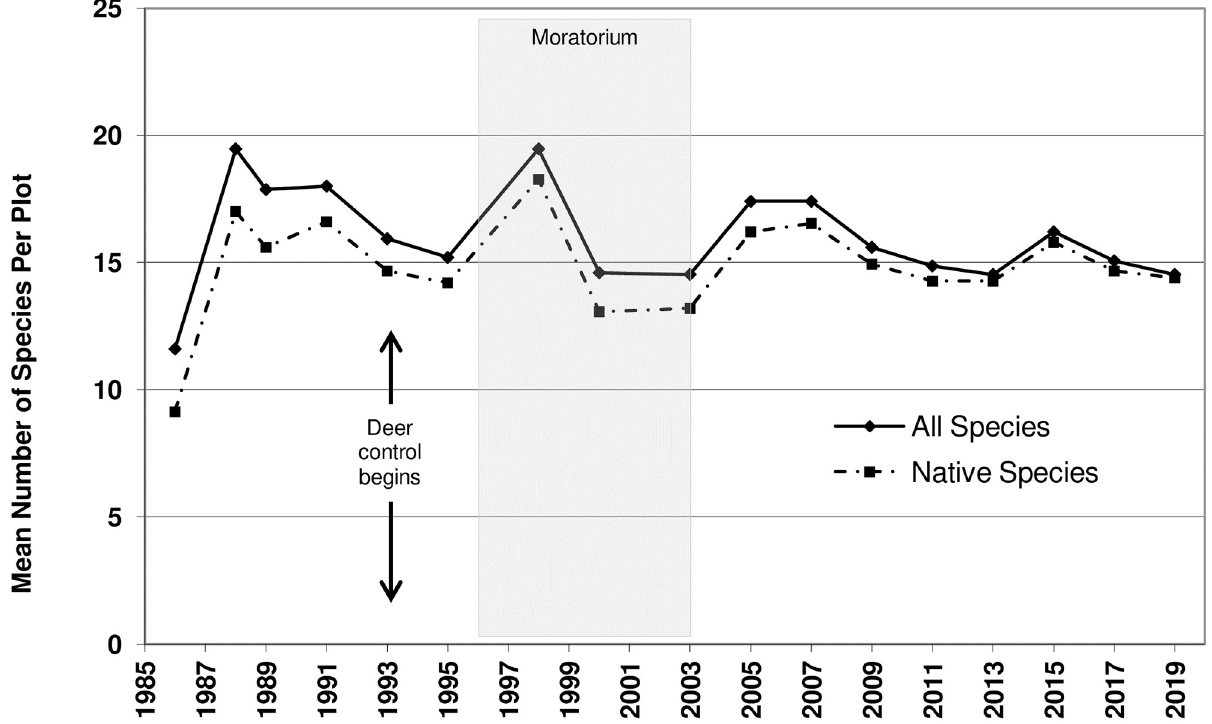
Fig 1. Species richness, represented as the mean number of species per plot. Time series analysis used the mean value of all species for each year sampled. Arrows represent the onset of deer culling, which continued thereafter. Shaded area represents the vegetation management moratorium years.